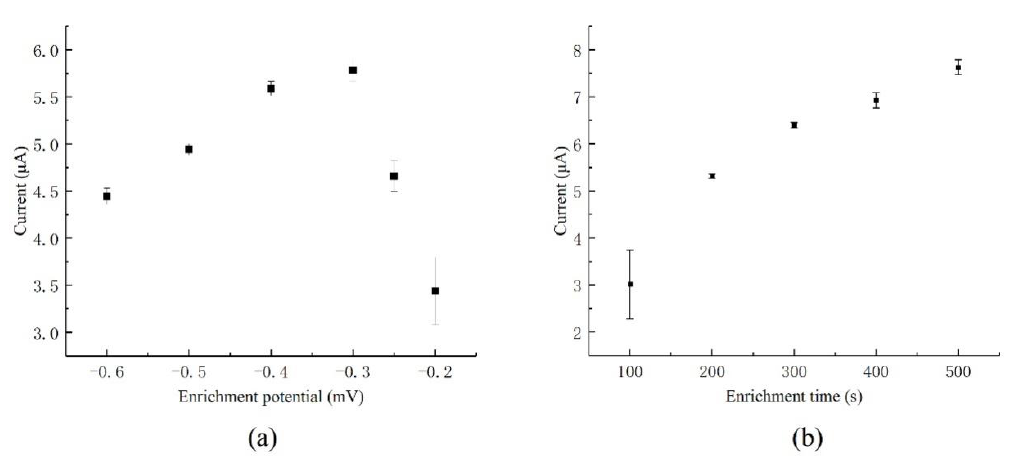
Figure 7. Optimization of detection parameters for the ultramicro interdigital electrode: ( a ) optimization of enrichment potential; ( b ) optimization of enrichment time. (The detection results are the average of three times).